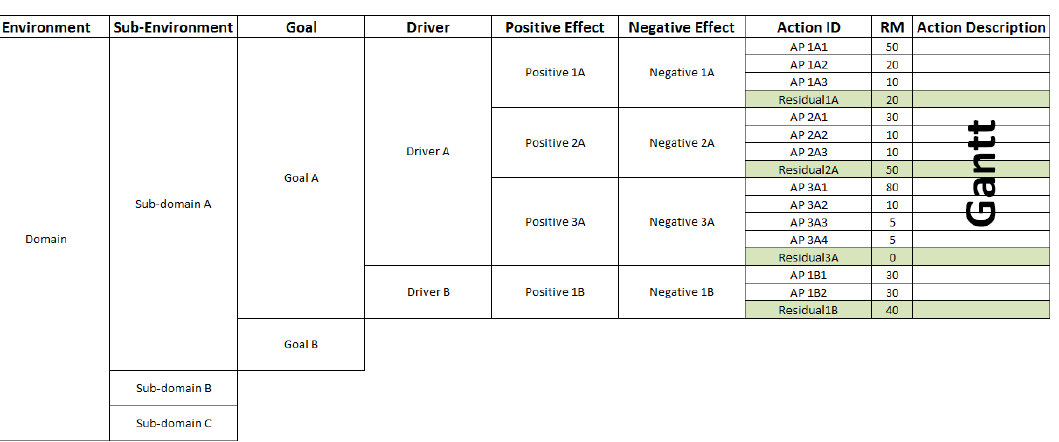
Figure 5. Force field analysis to Gantt. Figure 2. Force field analysis to